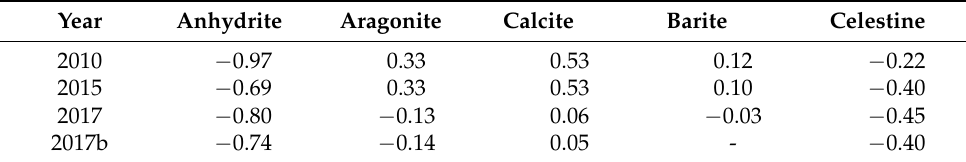
Table 6. Saturation index (SI) for selected minerals over